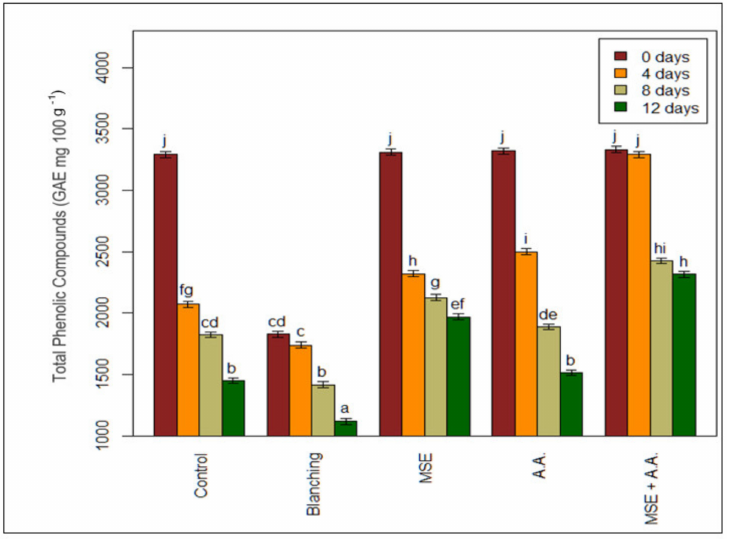
Figure 3. Effect of ascorbic acid (AA), mucilage seed extract (MSE), MSE + A.A, and blanching on total phenolic compounds (GAE mg 100 g − 1 ) of fresh-cut potato strips. (Means with the same CLD letter are not statistically significantly different. Letters come from holm-corrected multiple comparisons, across all times and